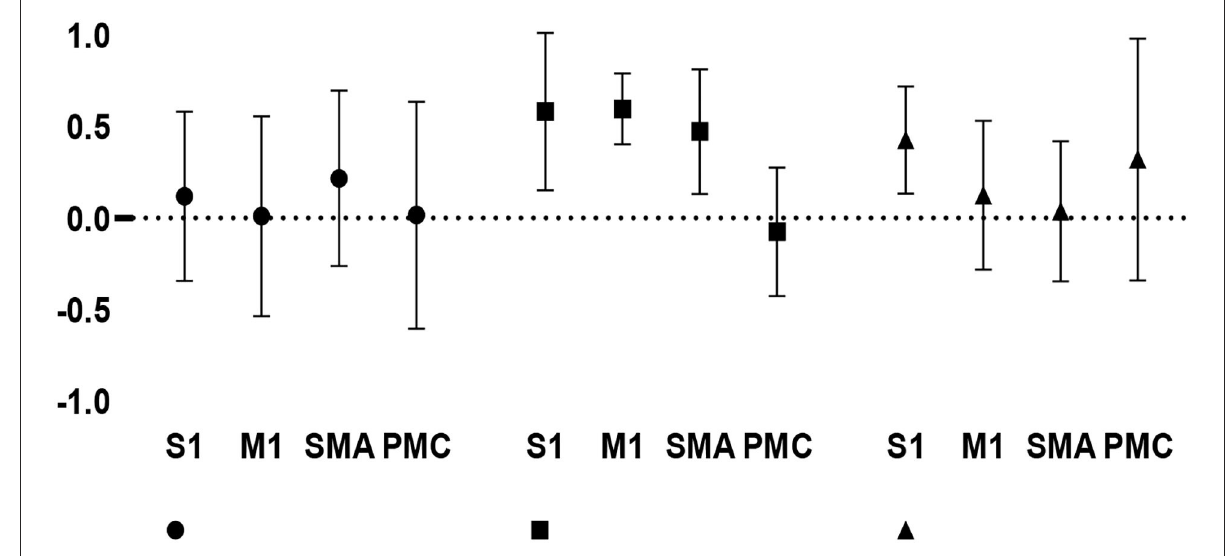
FIGURE6 Changes in interhemispheric regional activation asymmetry during gait in the three groups, as measured by